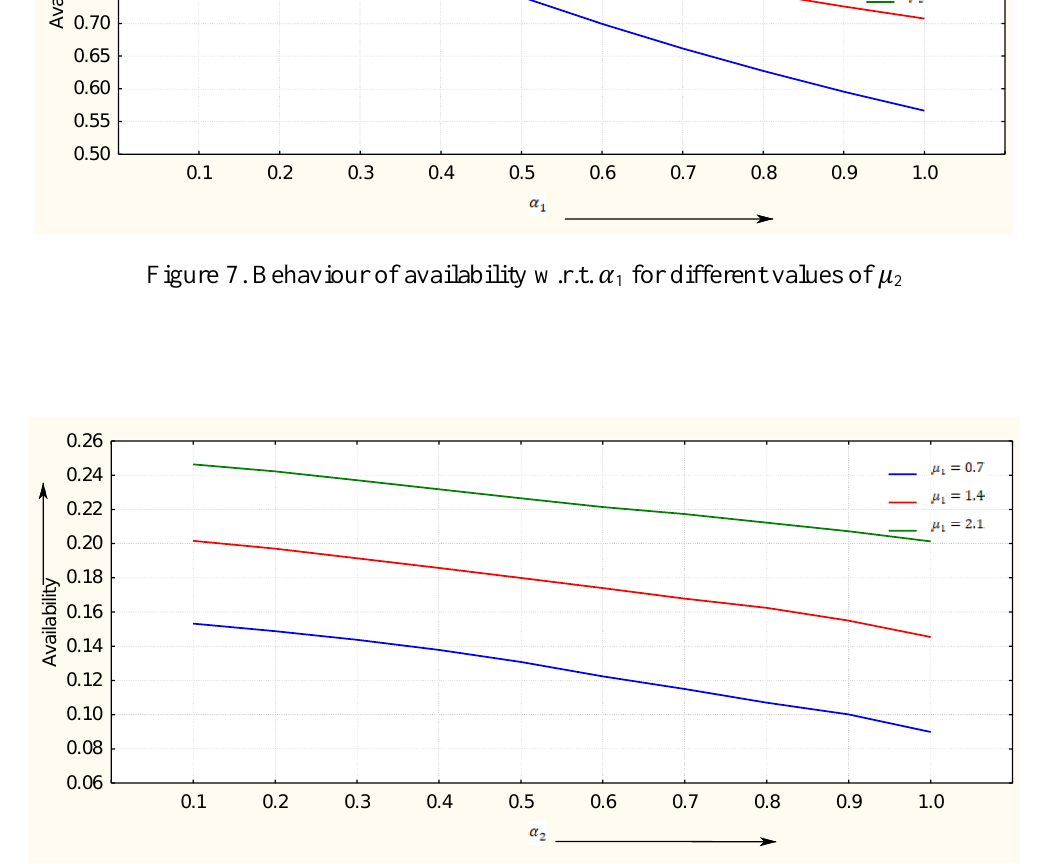
for different values of 𝜇 2